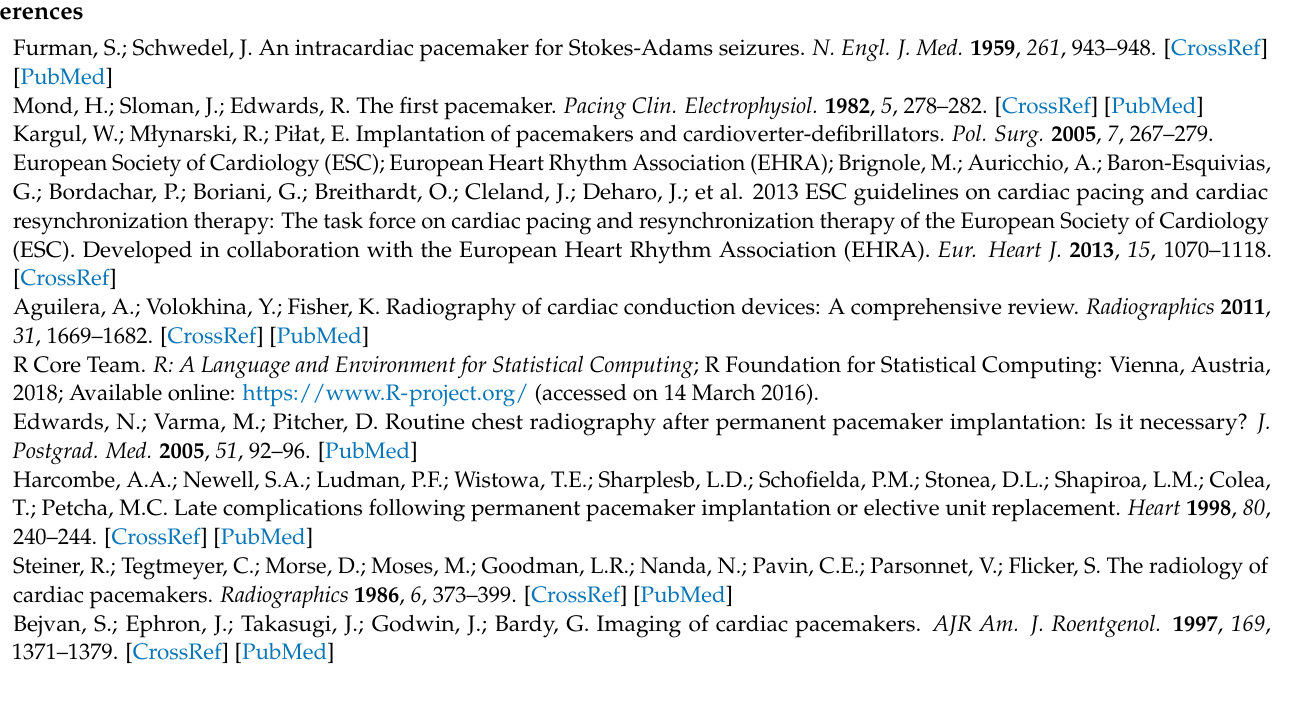
Table A1. Cont. Parameter Description The distance from the end of the atrial lead (tip) up to the right atrial line (b). Ah Measurement taken perpendicular to the right intra-sternal line (b). The distance from the end of the atrial lead (tip) up to the line of the Av diaphragm domes (i). Measurement carried out parallel to the right intra-sternal line (b). The intersection angle of two semi-rectangular lead structures in the center, in the area of the tricuspid valve 20 mm in the proximal and distal direction of the lead. Intersection angle of two semi-rectangular lead structures in the center, approximately 15 mm below the tricuspid valve. Half-straight lines were Epsilon angle determined as the tangent of the lead 20 mm in the proximal and distal directions of the lead. The intersection angle of the two semi-straight lines determined to the lowest point of the ventricular lead (dzeta 2), directed towards the implantation destination (tip—zeta 3). Half straight line 1 was determined to be closer to 20 mm from point dzeta 3. Distance from the end of the ventricular lead (tip) up to the left lateral sternal Vh line (c). Distance from the end of the ventricular lead (tip) up to the line of the Vv diaphragm domes (i). In the case where the lead tip was down from line (i) the value was